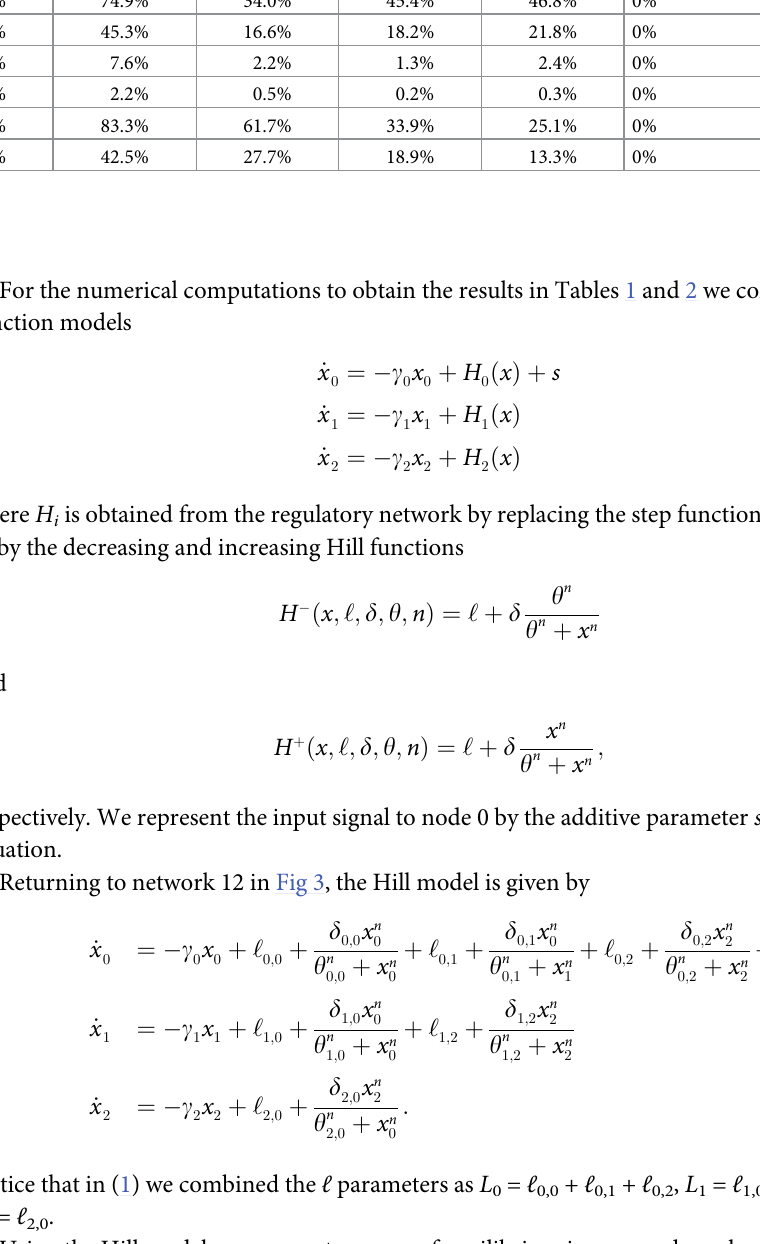
� FP ð 1 Þ � FP ð 2 Þ and the second column assume 0